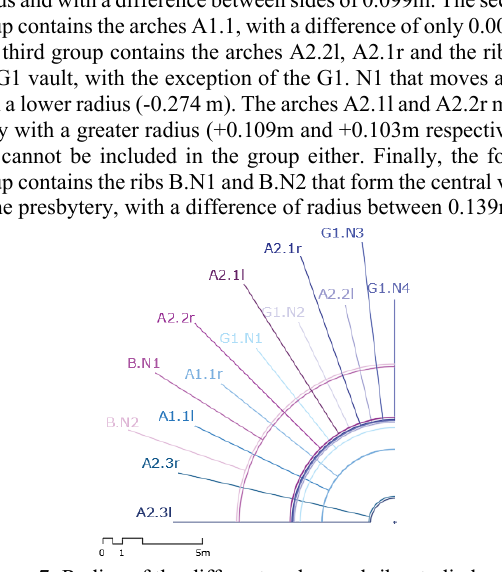
Figure 7: Radius of the different arches and ribs studied.